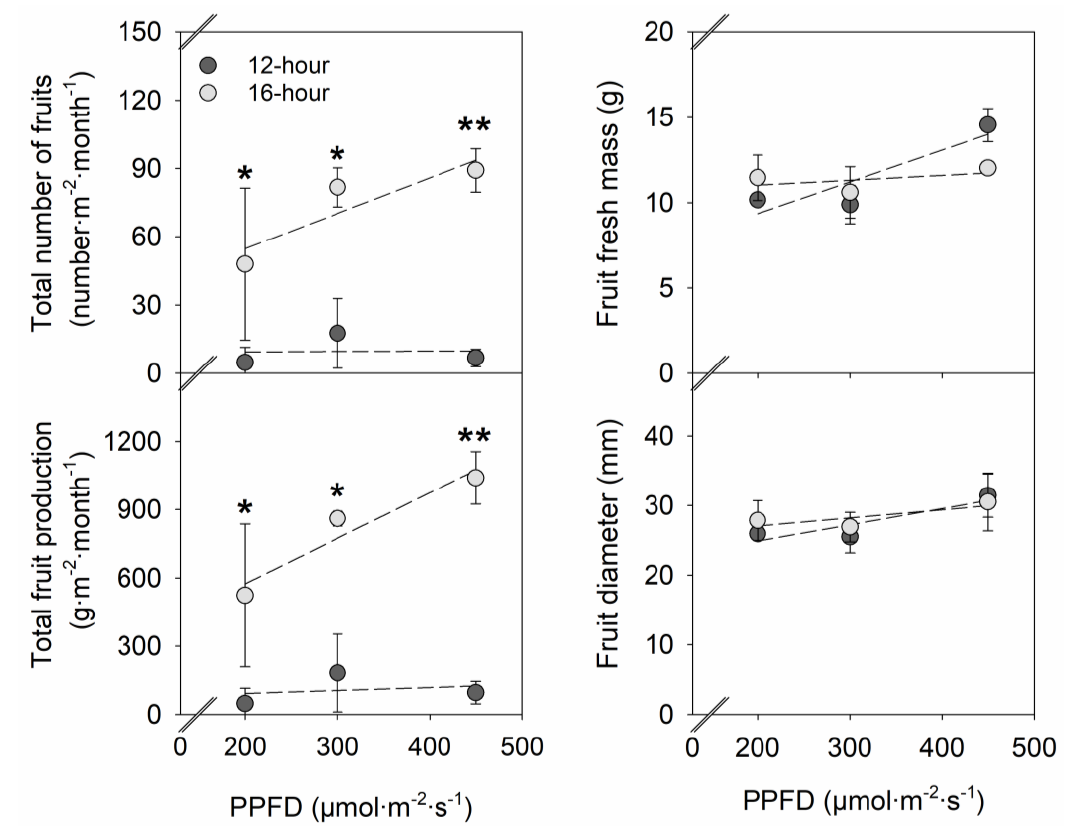
Figure 5. Influences of photosynthetic photon flux density (PPFD) and photoperiod of sole-source lighting treatments on total number of fruits, total fruit production, individual fruit fresh mass, and individual fruit diameter of strawberry ‘Albion’. Each data point represents the mean and standard deviation of two replications (n = 2). At each photoperiod, linear relationship with PPFD is indicated with dashed line when insignificant ( p ≥ 0.05). At any PPFD, * or ** indicates a significant difference at p < 0.05 or 0.01 at a 12-h or 16-h photoperiod,